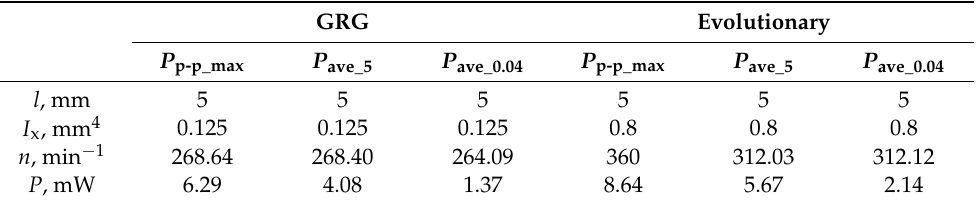
Table 5. Design parameters resulting in the highest powers, obtained via the two considered opti- mization